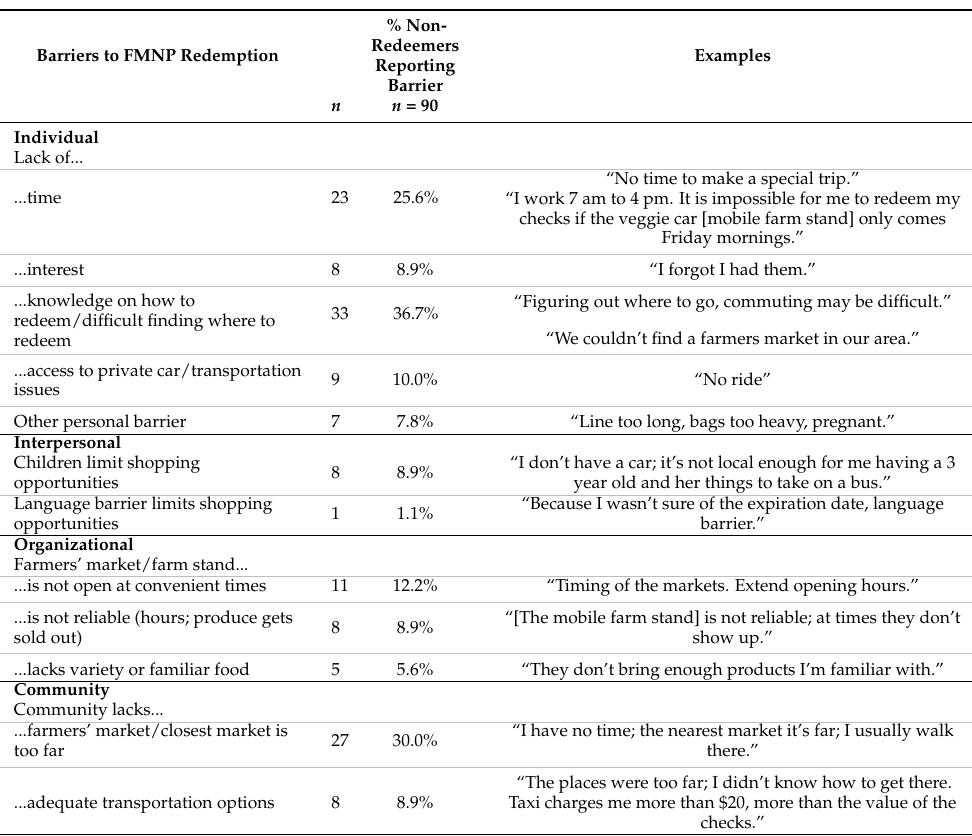
Table 5. Analysis of Open-Ended